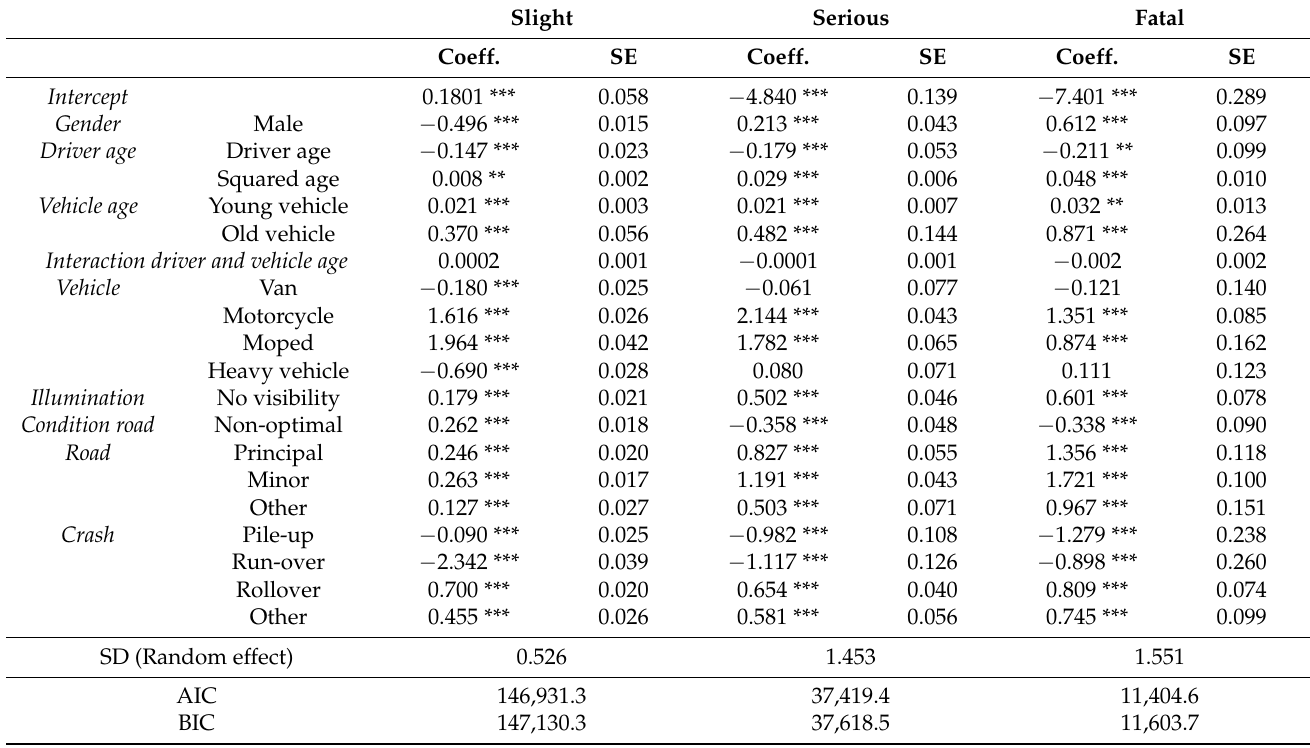
Table 4. Coefficient estimates of the binomial GLMM according to BI severity of